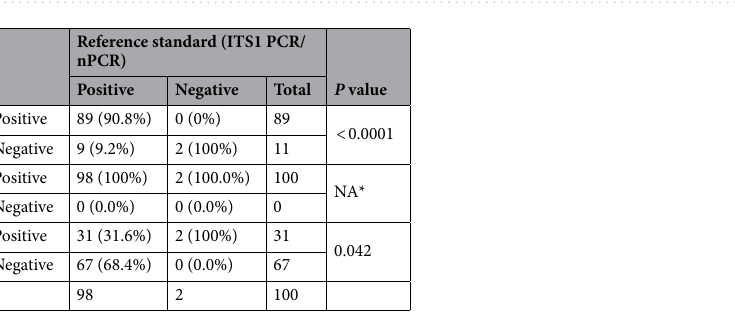
Table 2. Results of direct ITS1 PCR, kDNA PCR and microscopy of stained smear in detection of CL among all study individuals. *NA: No statistics are computed because kDNA is a constant.